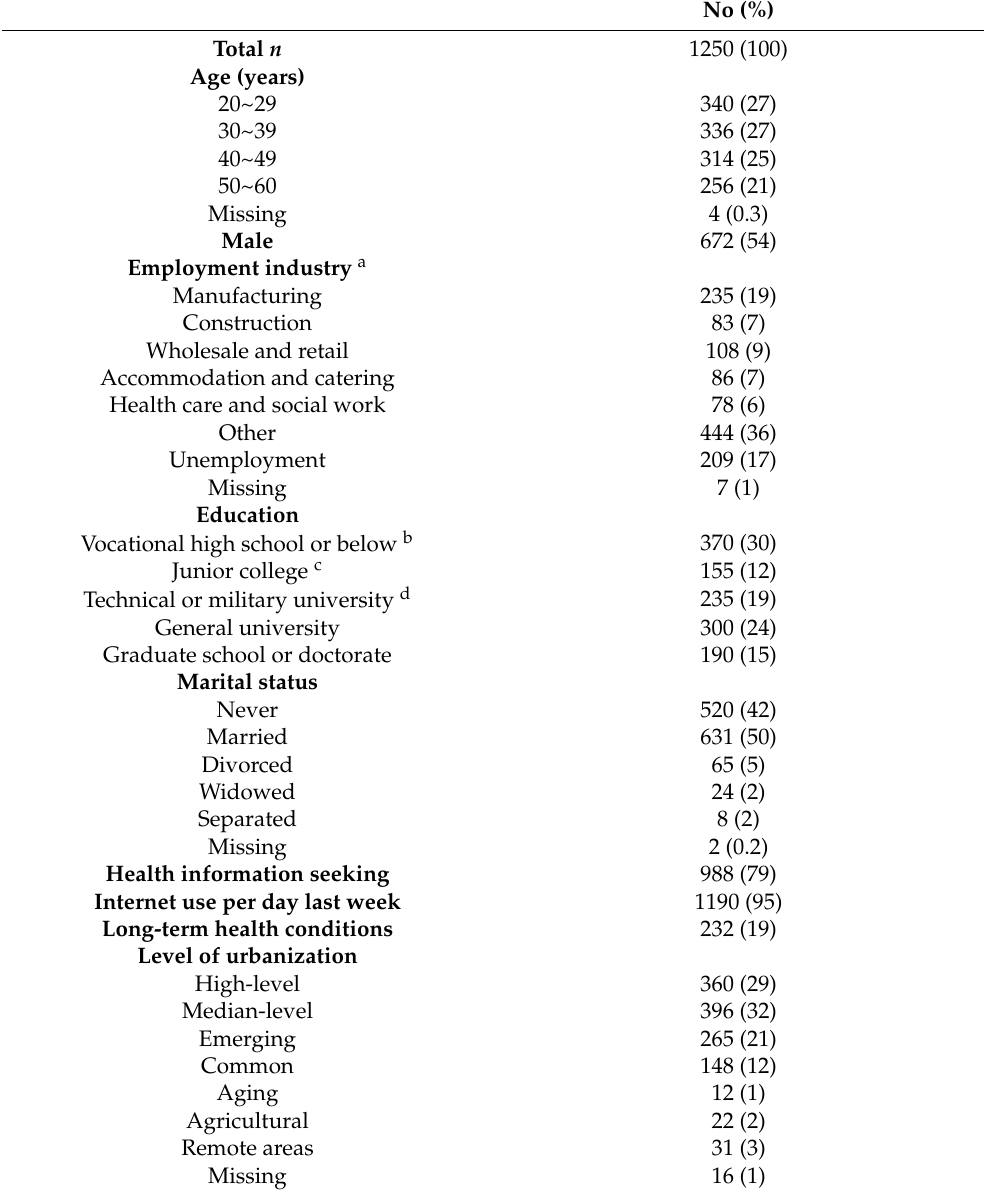
Table 1. Characteristics of the study